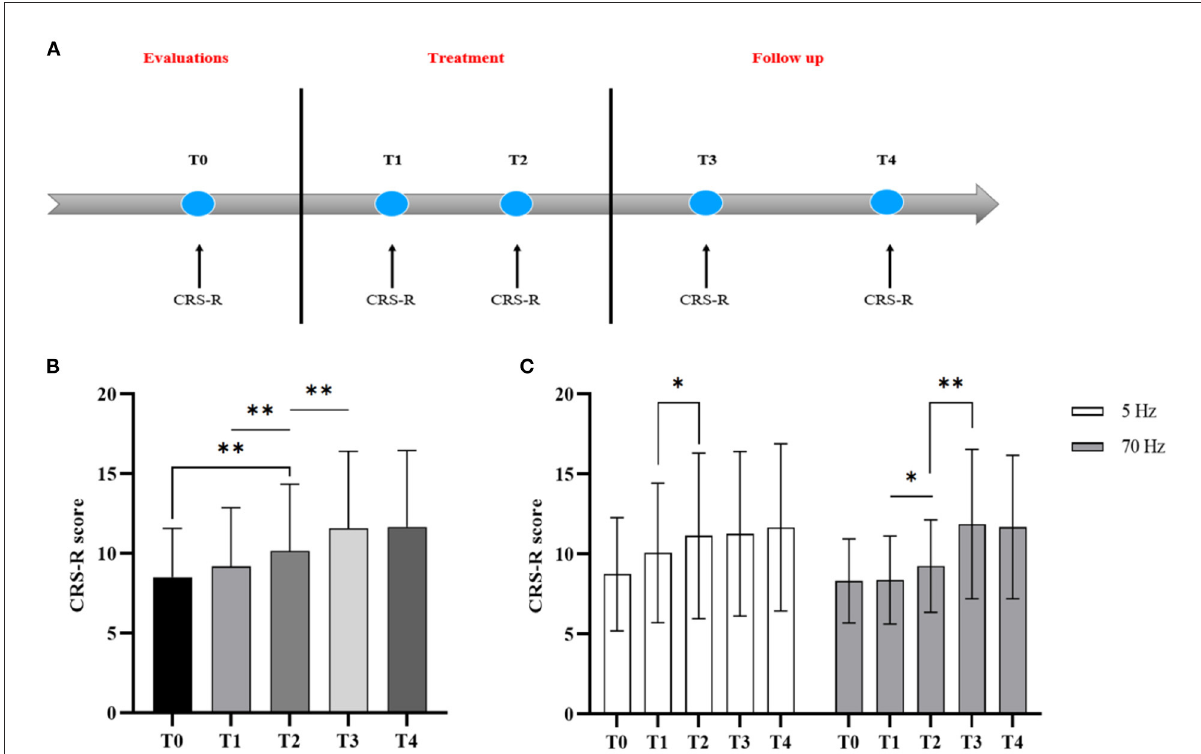
FIGURE5 CRS-R changes with treatment going at five-time points: before the treatment (T0), treatment of 1 week (T1), treatment of 2 weeks (T2), 1 week after treatment (T3), and 3 months follow-up (T4). (A) Study protocol timeline showing treatment effects of stSCS evaluated with CRS-R, (B) CRS-R changes at five-time points, (C) CRS-R changes of different frequency groups at five-time points. Asterisk indicates significant differences based on One-way RMANOVA (* p < 0.05; ** p <